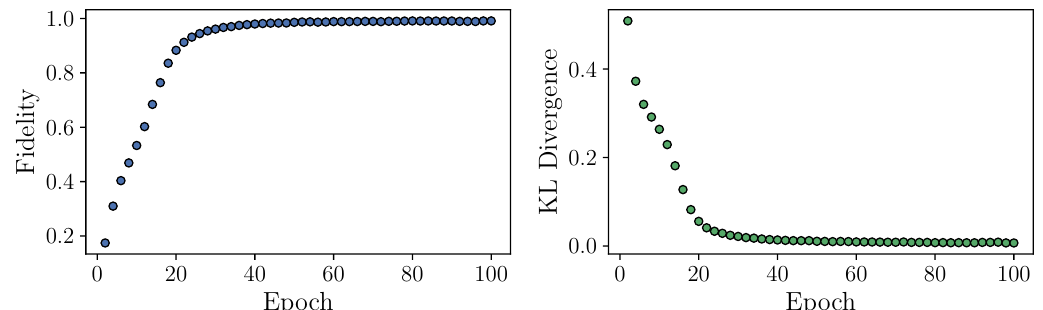
Figure 5: Training a complex RBM with QuCumber on random two-qubit data. We show the fidelity (left), and KL divergence (right), as a function of the training